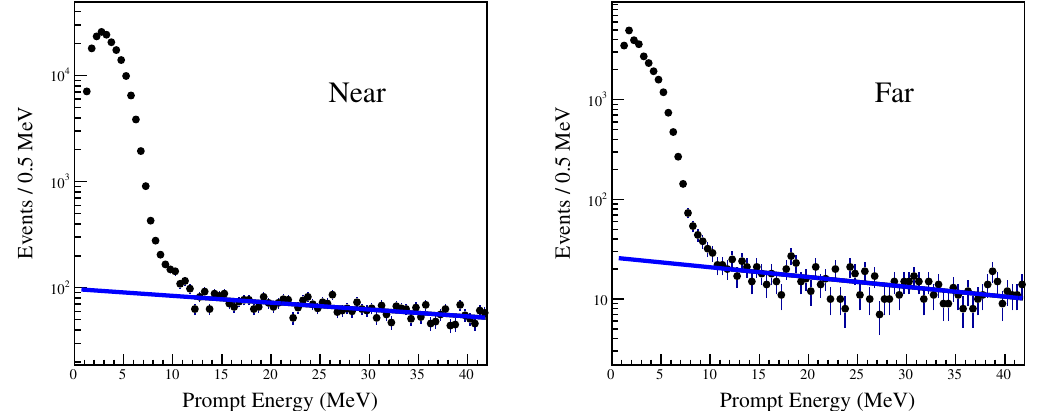
Figure 10 . Prompt energy spectra of IBD candidates and fast neutron background. The remaining rate of fast neutron in the IBD candidates is estimated by extrapolating from the background dominant region assuming an exponential spectrum of the background. The slope of exponential spectrum is measured to be 0.017 (cid:6) 0.001 (0.025 (cid:6) 0.002) in the near (far)